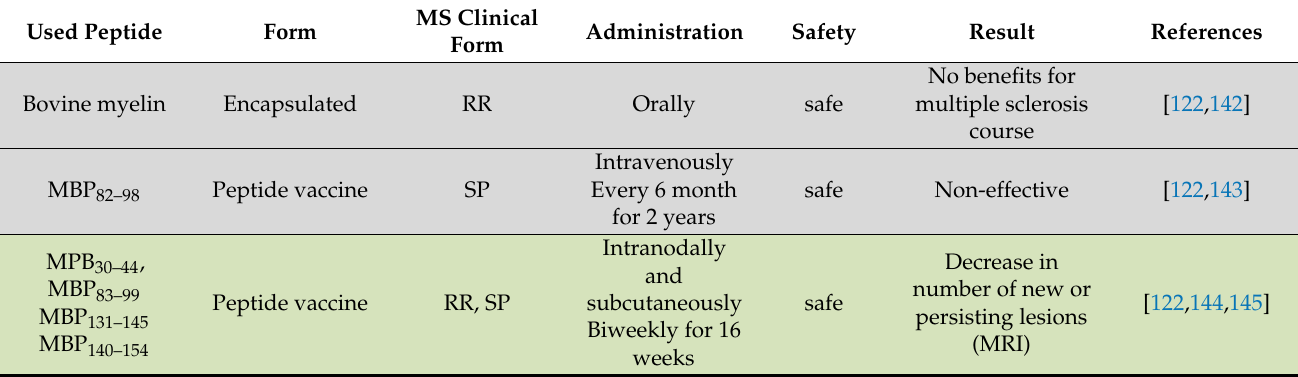
Table 2. Clinical trial results for myelin antigen use as a therapeutic options in multiple sclerosis. Trials without any beneficial effect are labeled with black shade; trials with strong side effects are labeled with red shade; trials with positive results are labeled in green. Used